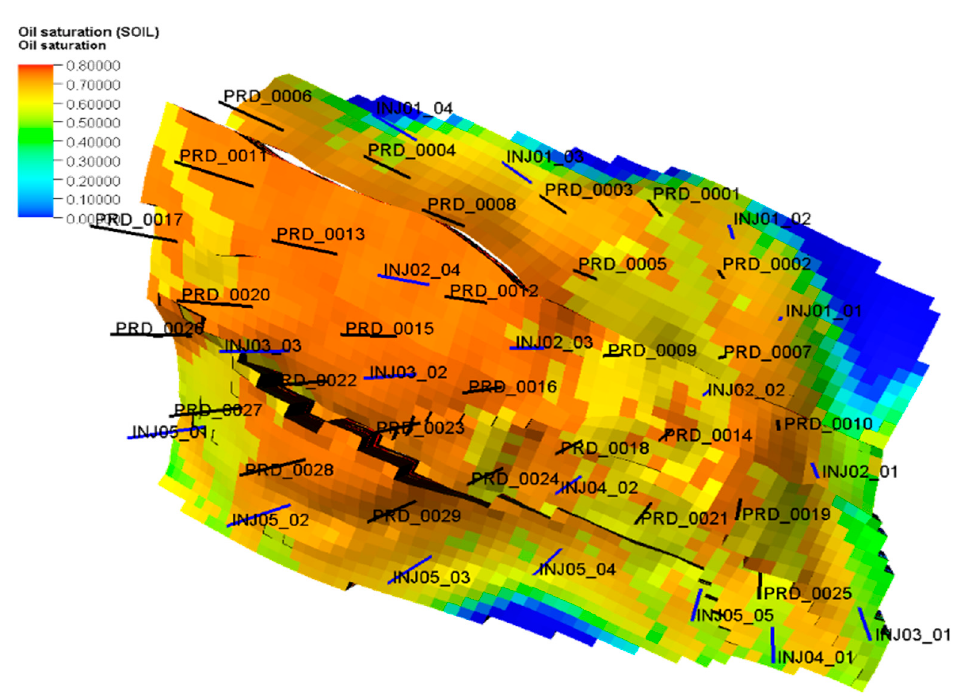
Figure 1. The RAA4 field and distribution of wells. Figure 2 presents the field performance.